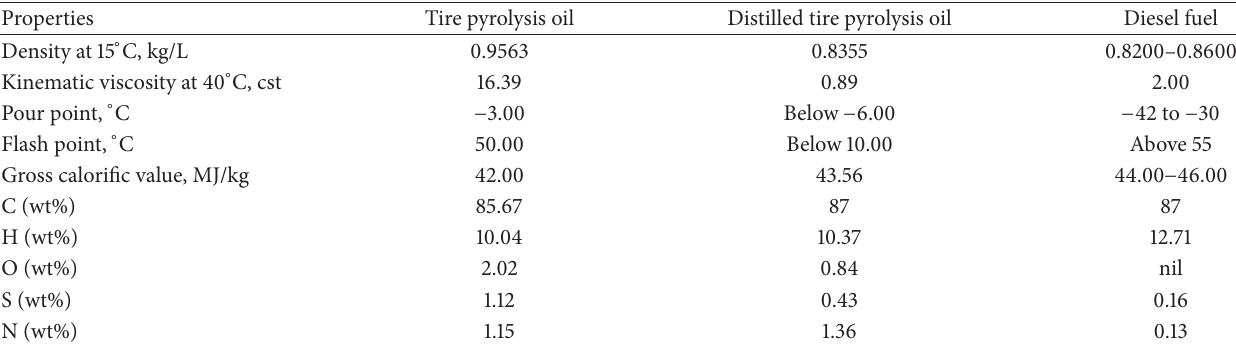
Table 2: Properties of TPO, DTPO, and diesel fuel.